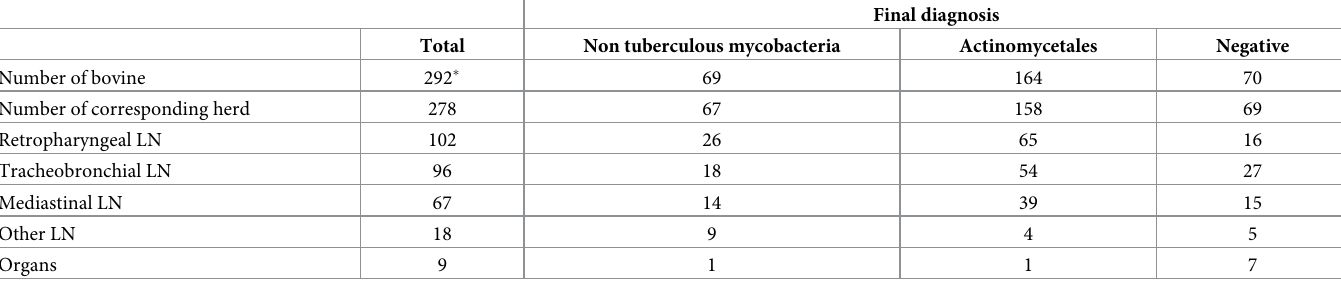
Table 2. Number of histology +/PCR—Samples analysed and final diagnosis (bacteriology or molecular) obtained at the National Reference Laboratory for